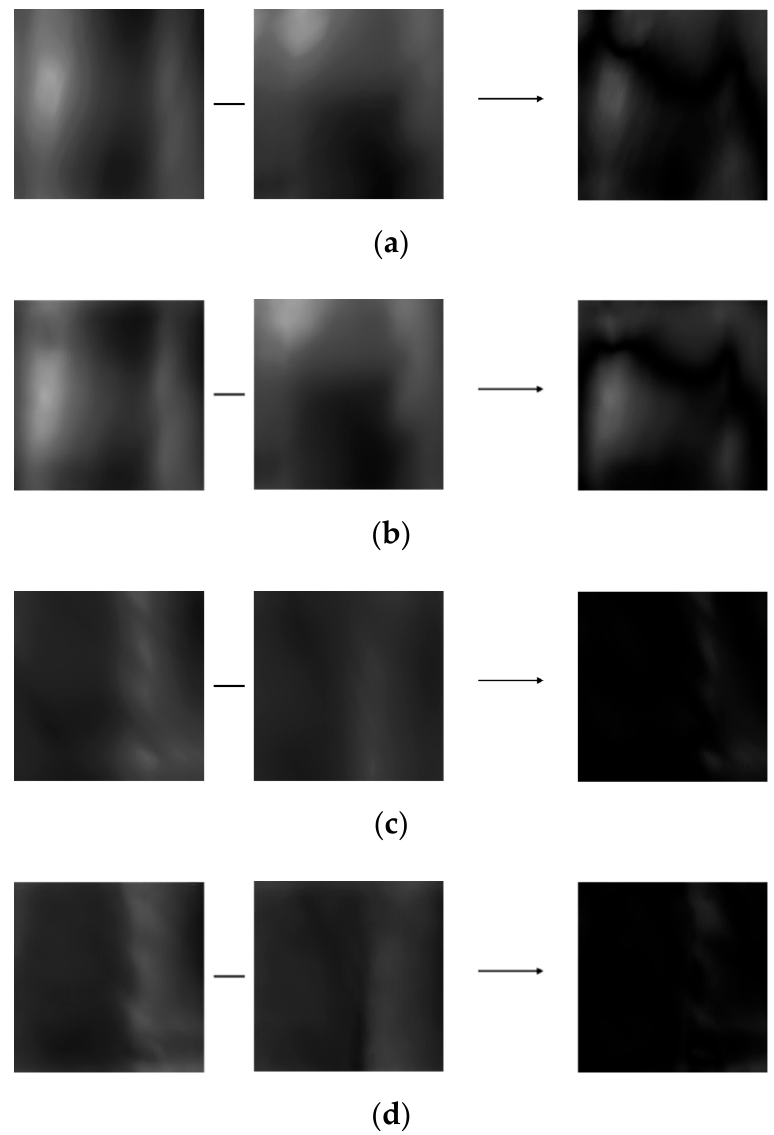
Figure 19. Incorrect recognition examples after restoring motion blur. ( a ) Incorrect genuine matching before restoring motion blur, ( b ) incorrect genuine matching after restoring motion blur, ( c ) incorrect imposter matching before restoring motion blur, and ( d ) incorrect imposter matching after restoring motion blur. From the left, examples in ( a – d ) present the registered, input, and difference images, respectively.